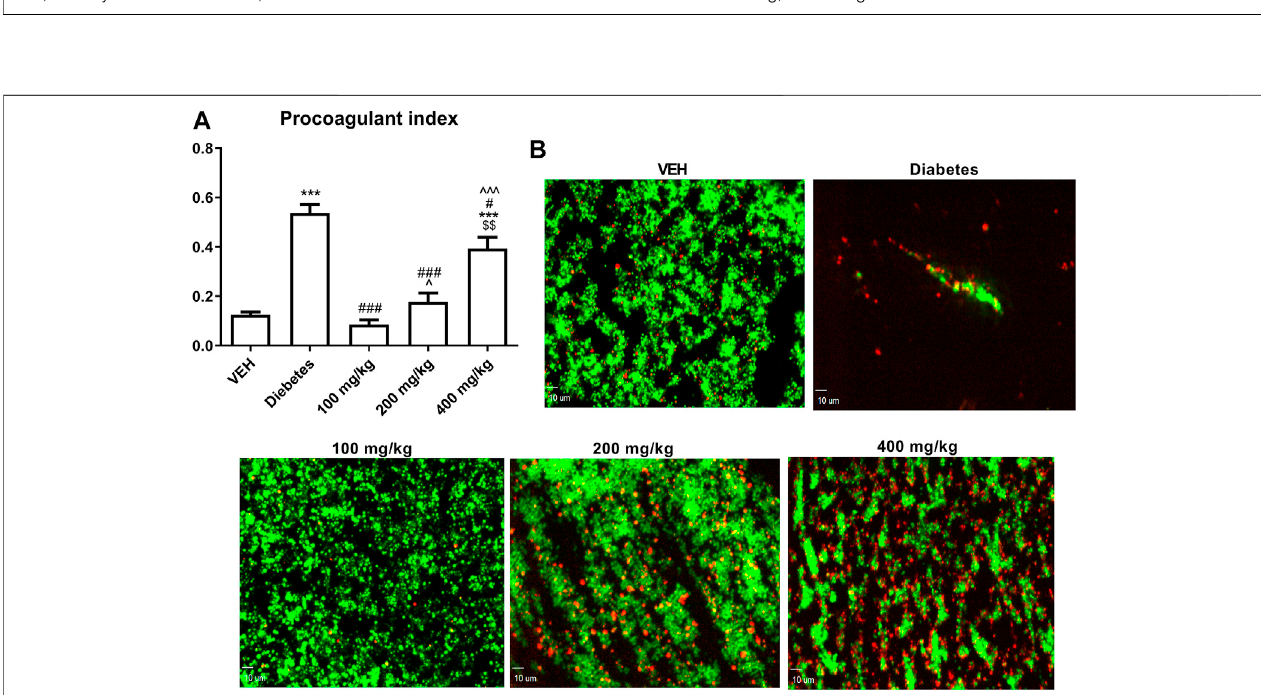
FIGURE4| TheeffectofTEonPI (A) .RepresentativeconfocalmicroscopyimagesofthrombusconsistingofPS-negativeplatelets(green)andPS-positiveplatelets (red). Bar (cid:2) 10 µm (B) *** p < 0.001 vs. VEH; # p < 0.05, ### p < 0.001vs. Diabetes; ^ p < 0.05, ^^^ p < 0.001 vs. 100 mg/kg; $$ p < 0.01 vs. 200 mg/kg; n (cid:2) 8 – 11. Data are shown as mean ± SEM.